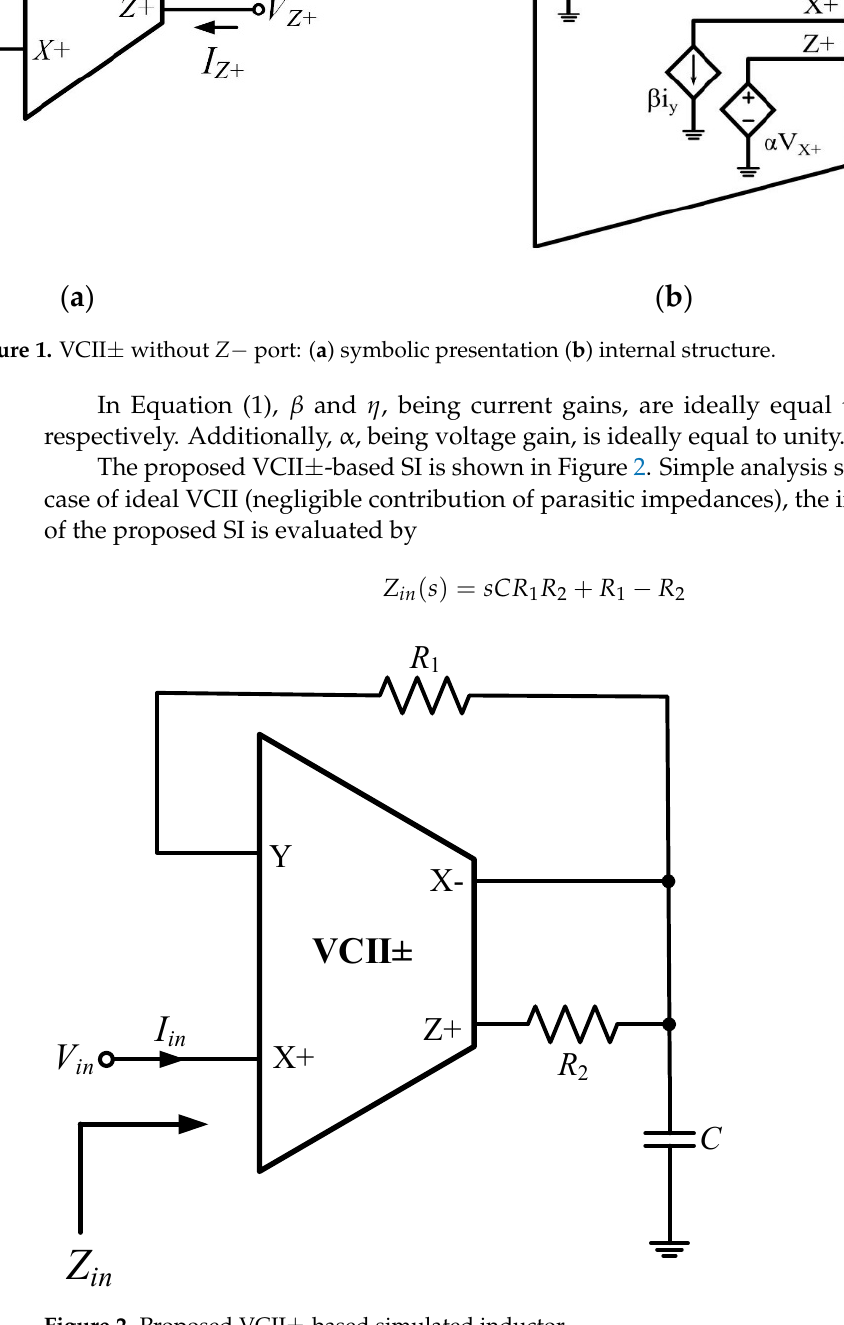
Figure 1. VCII± without Z − port: ( a ) symbolic presentation ( b ) internal structure.